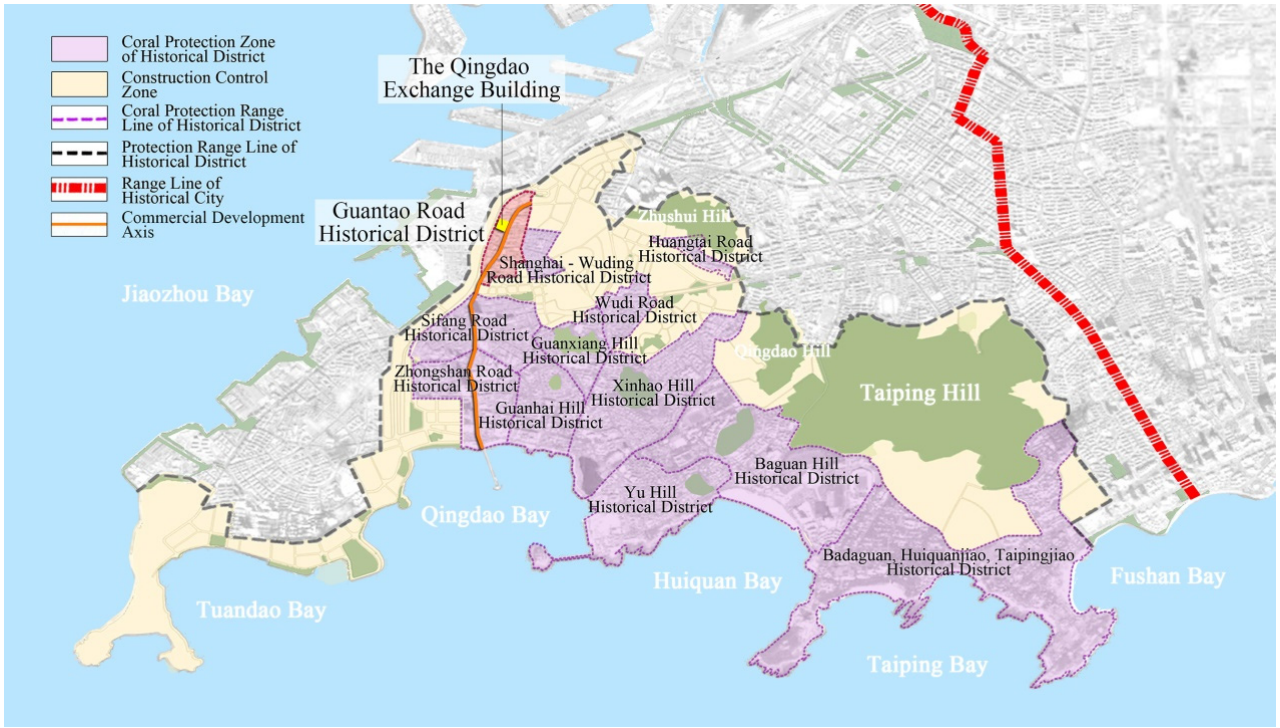
Figure 19. Conservation Plan of Historical City of Qingdao (2011–2020) (based on the Protection Planning for National Famous Historical and Cultural City of Qingdao from 2011 to 2020 by Natural Resources and Planning Bureau of Qingdao).